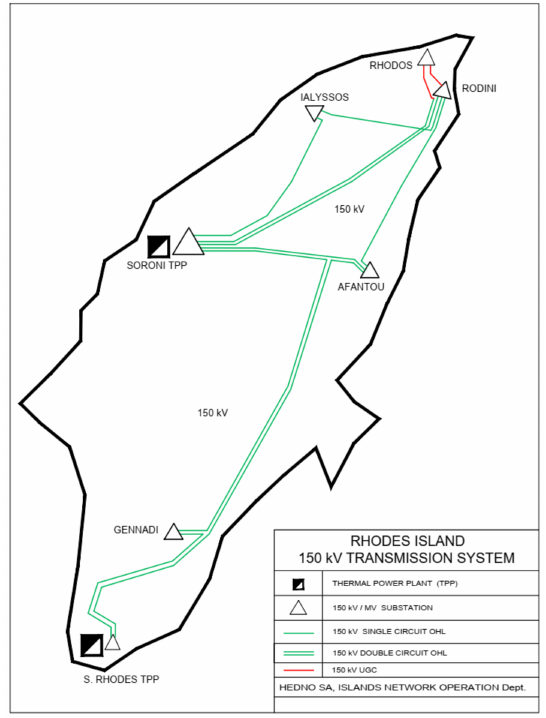
Figure 1. Rhodes 150 kV transmission